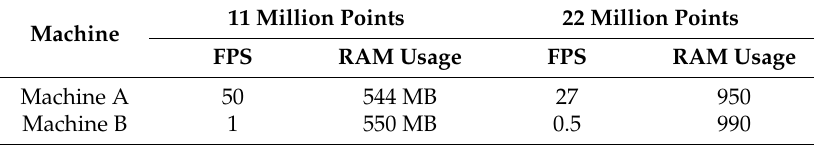
Table 3. The performance of large-volume data visualization on different